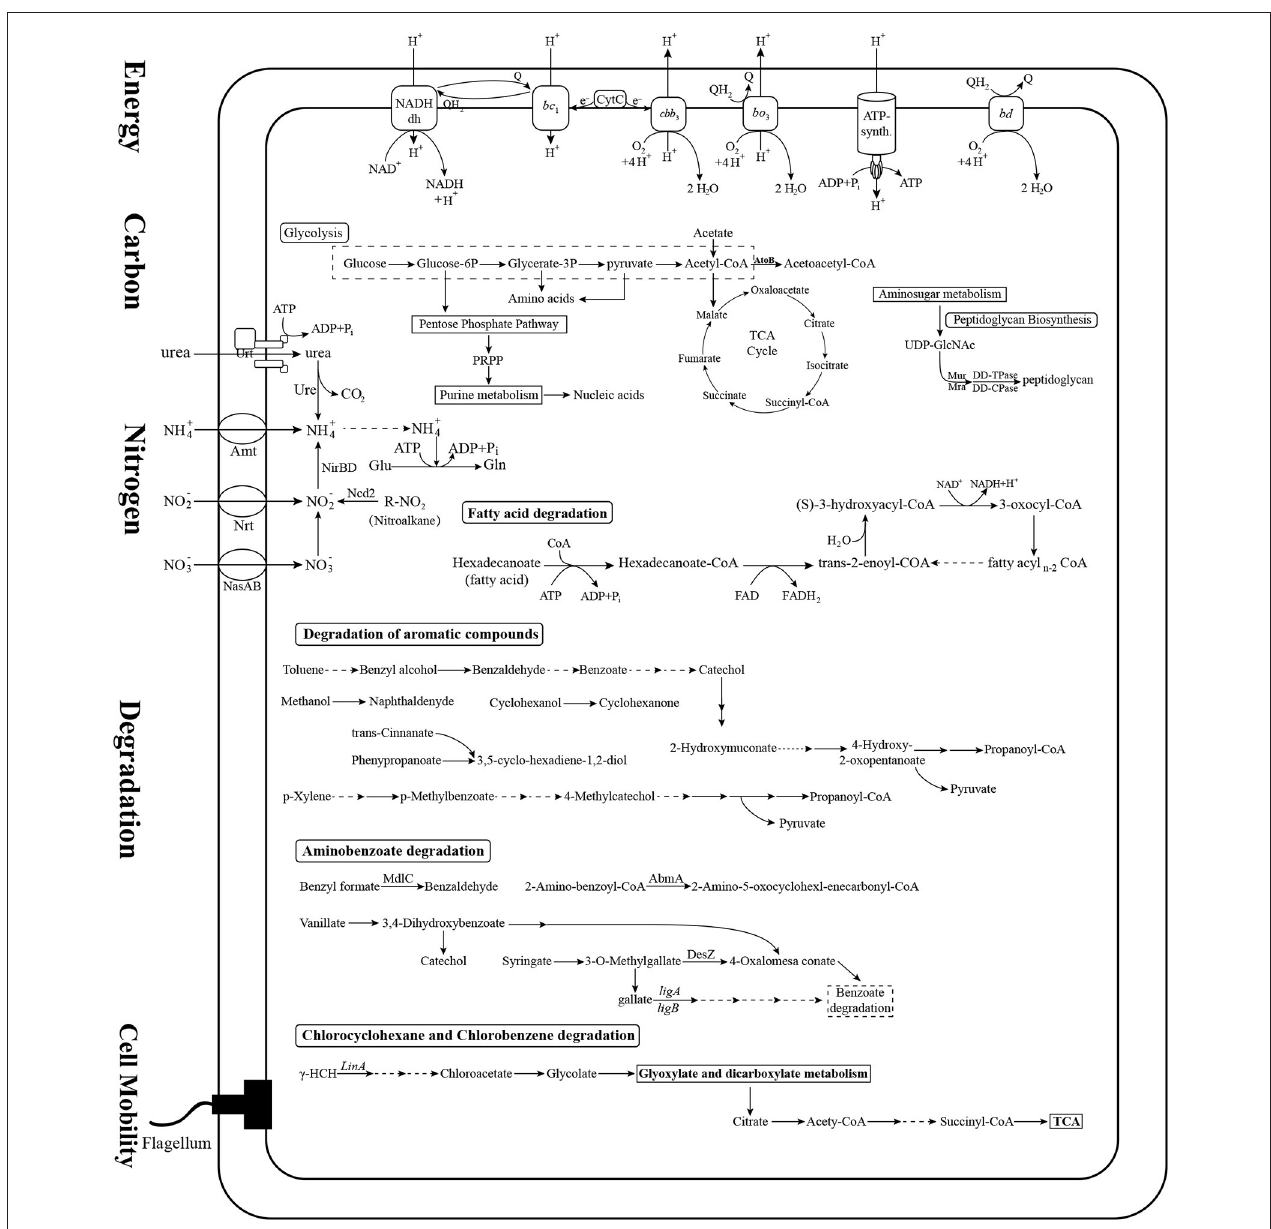
FIGURE 4 | Prediction of the central metabolic potential of 22 Novosphingobium strains. Potential metabolic traits associated with carbon, nitrogen, energy metabolism, and degradation pathways were analyzed. The genes predicted to be involved in these metabolic pathways are listed in Table S3 .